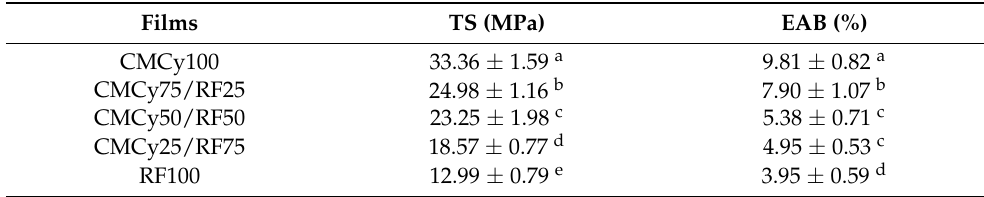
Table 2. Tensile strength (TS) and elongation at break (EAB) of the CMCy/RF composite biopolymer films produced in different